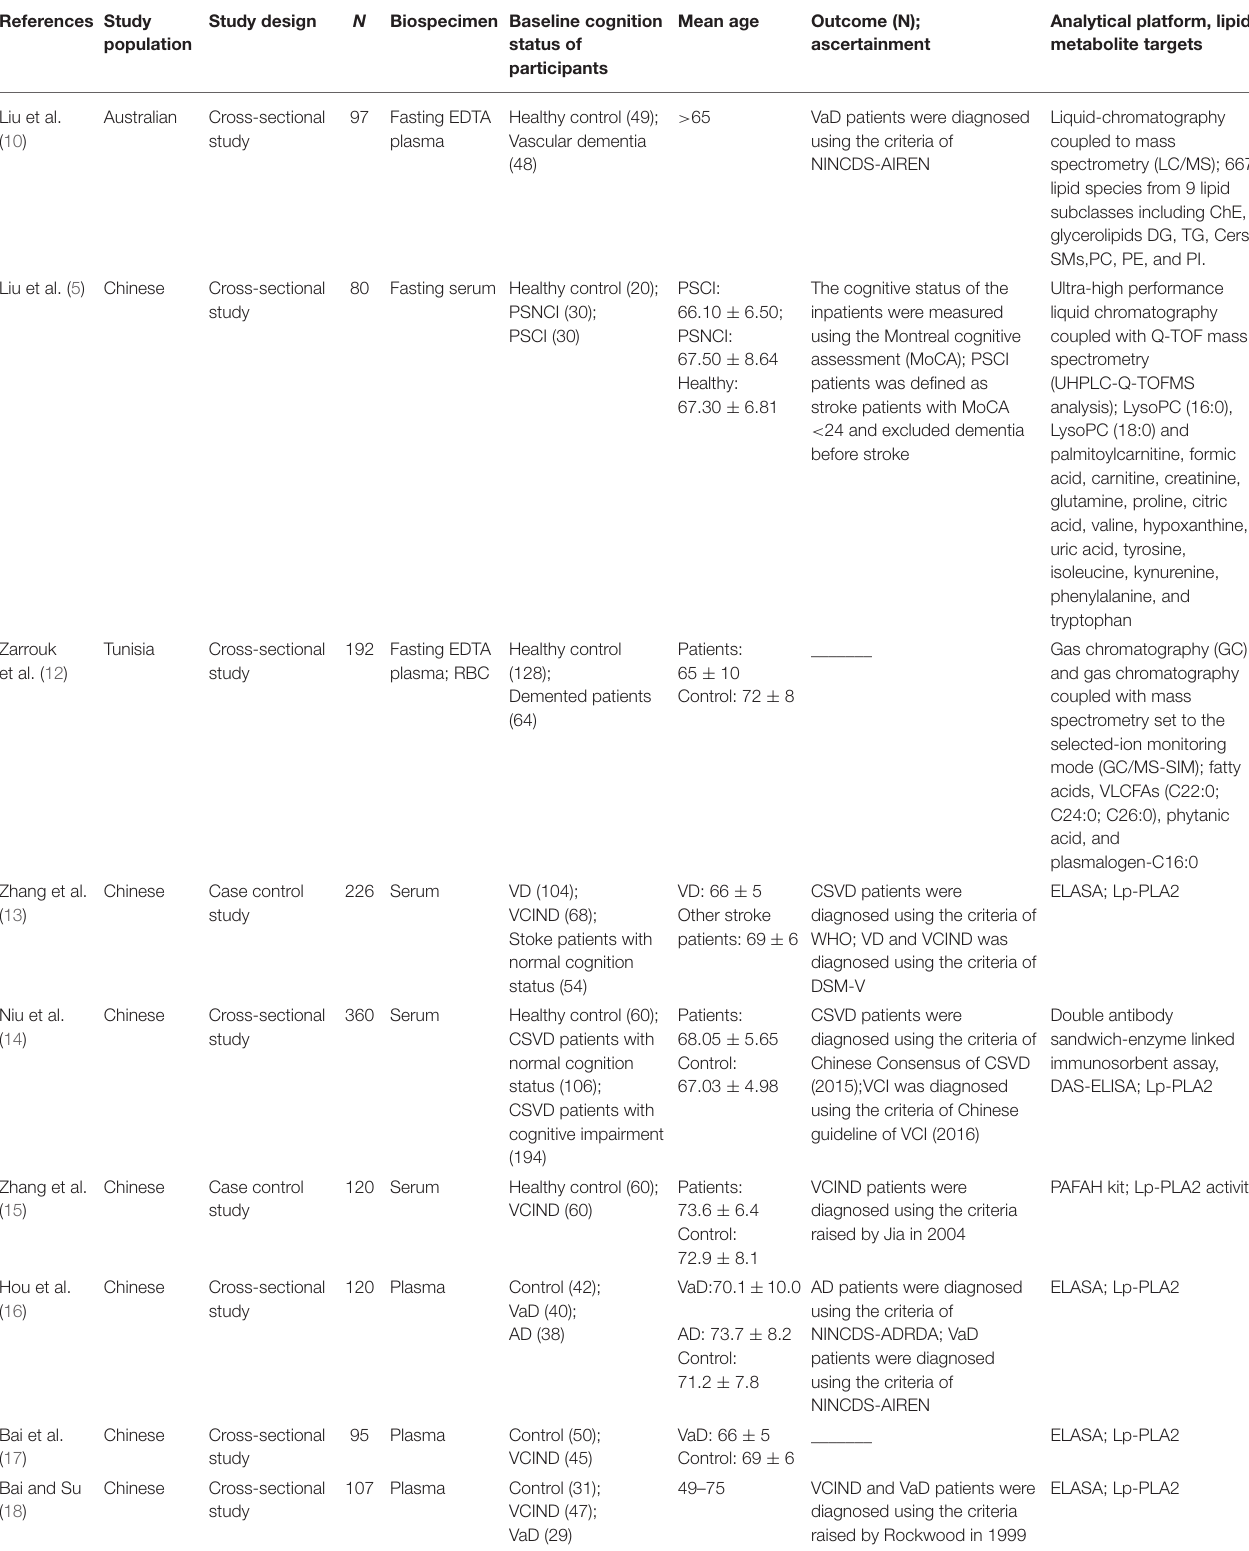
TABLE 1 | Characteristics of studies investigating associations between lipid metabolites and